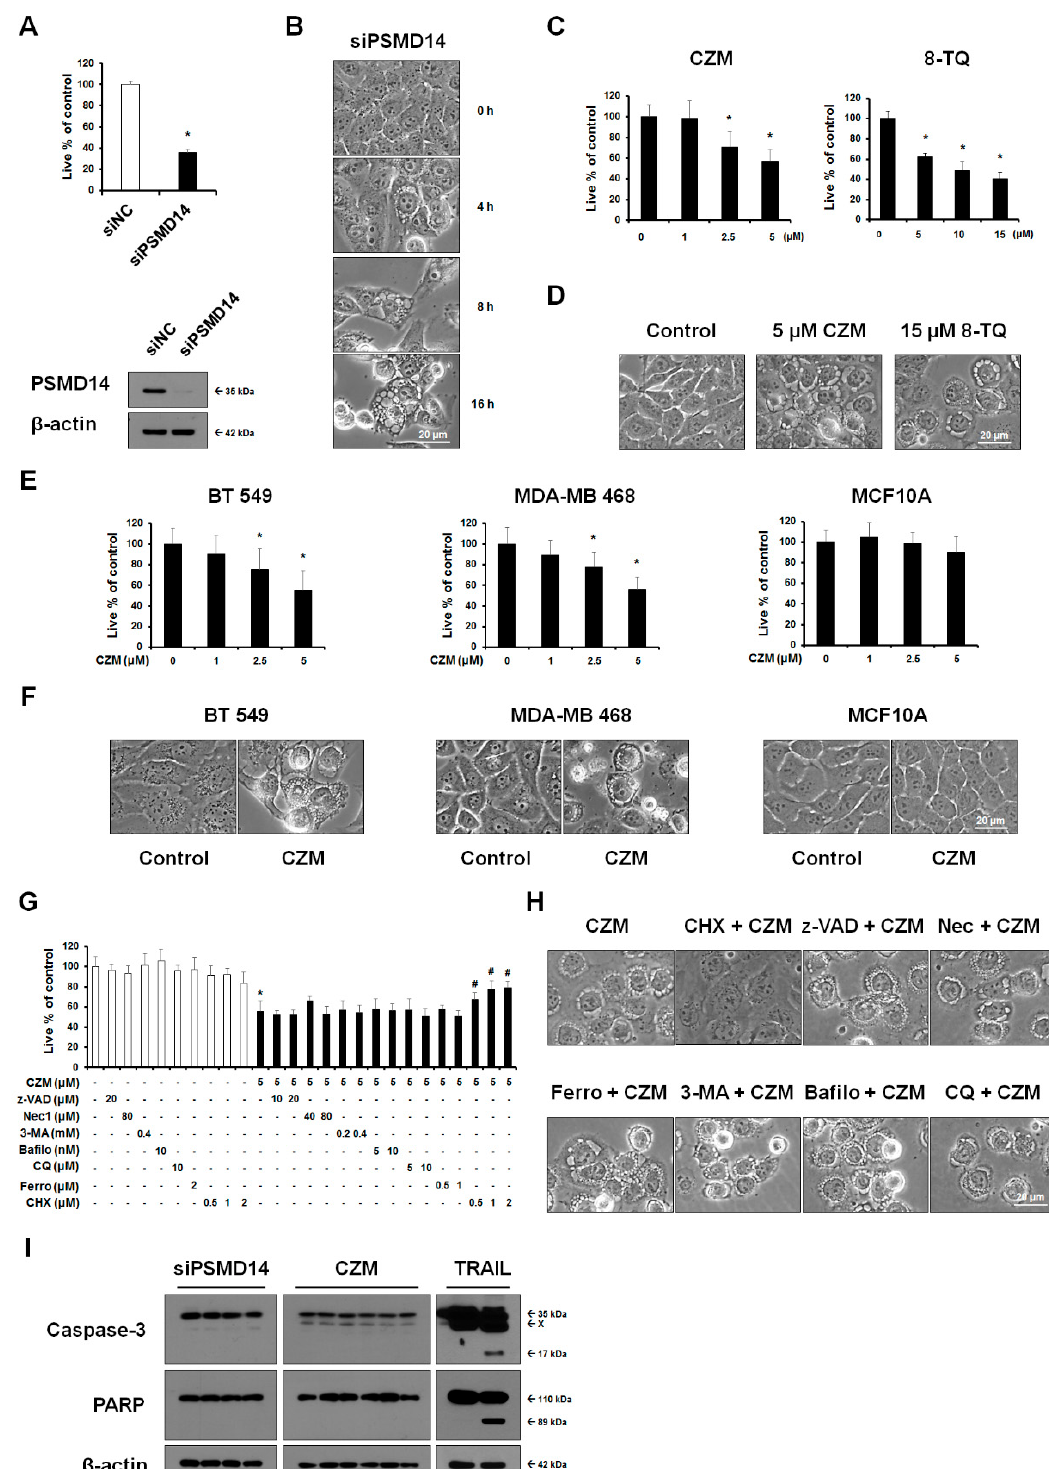
Figure 1. Targeting PSMD14 induces cell death accompanied by vacuolation in breast cancer cells but not in normal breast cells. ( A , B ) MDA-MB 435S cells were transfected with the siRNA against PSMD14. ( A ) Cellular viability was assessed, as described in Materials and Methods, and knockdown of PSMD14 was confirmed by Western blotting. * p < 0.001 vs. siNC-transfected cells. ( B ) Cells were observed by phase-contrast microscopy. Bars, 20 μ m. ( C , D ) Cells were treated with the indicated concentrations of CZM for 12 h or 8-TQ for 24 h. ( C ) Cellular viability was assessed using IncuCyte, as described in Materials and Methods. * p < 0.001 vs. untreated cells. ( D ) Cells were ob- served by phase-contrast microscopy. Bars, 20 μ m. ( E ) Cells were treated with the indicated concen- trations of CZM for 24 h, and cellular viability was assessed using IncuCyte. * p < 0.001 vs. control.